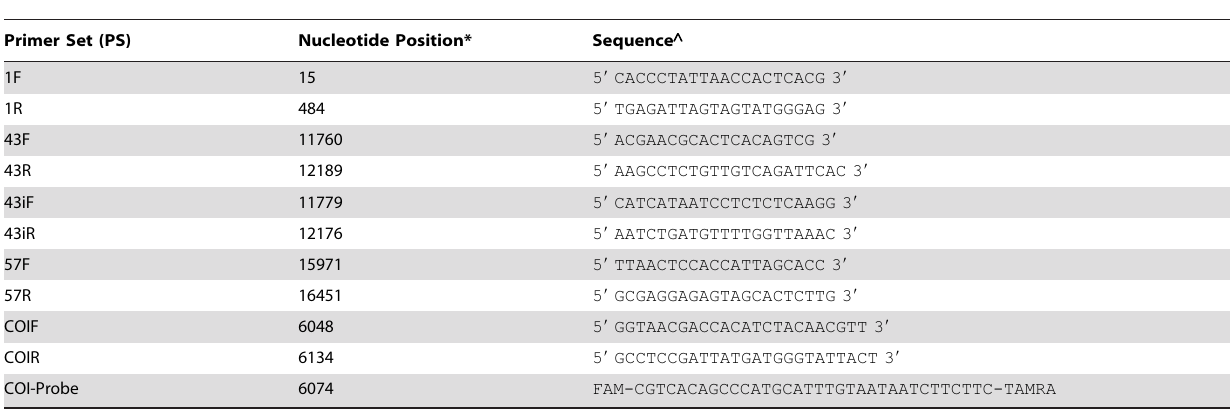
Table 3. Primer sequences used for PCR, sequencing and qPCR.